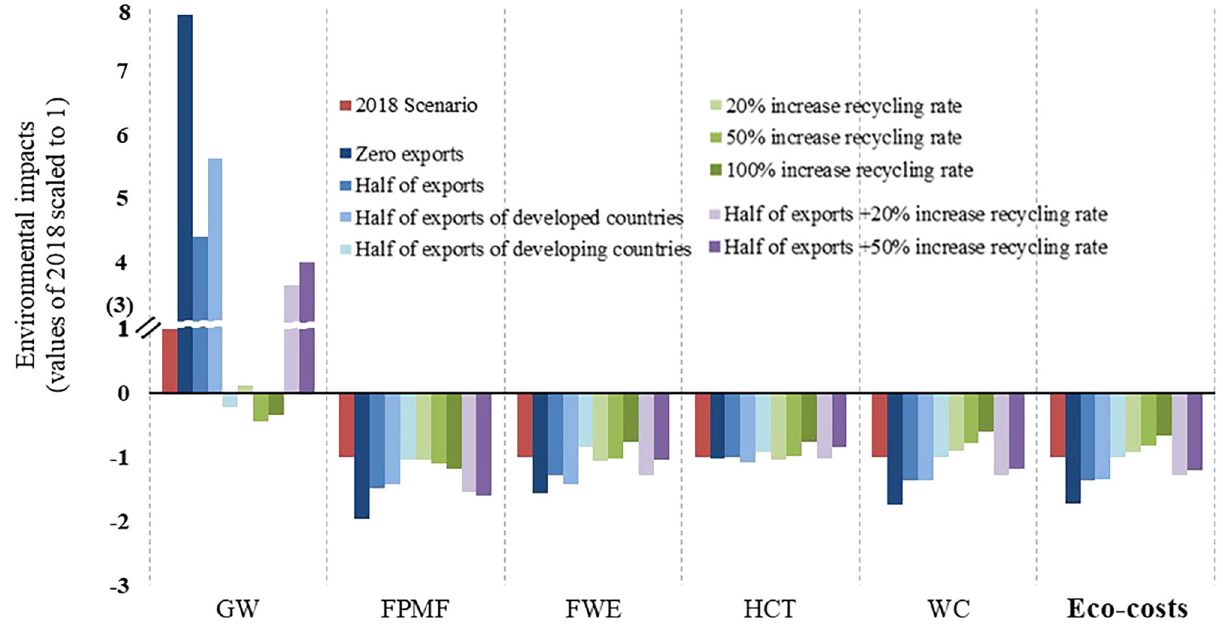
Fig. 5 Comparison of the environmental impacts of Exports Reduction Scenarios, Recycling Rate Promotion Scenarios, and Combination Scenarios. The data source can be found in Supplementary Table 9. The absolute value of each bar is equal to the absolute result of the actual value divided by its 2018